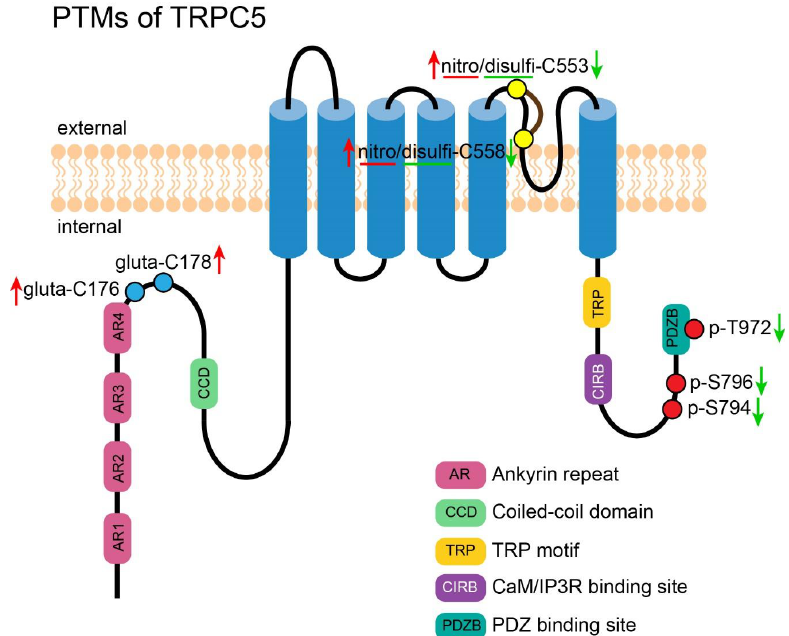
Figure 4. PTMs of TRPC5. A cartoon depicting TRPC5 with its important motifs and PTMs (those exact positions had been reported). PTMs are presented in circles. Red circles represent the reported phosphorylation sites of TRPC5, which are labeled in the format of a “p-amino acid-position”. Yellow circles represent the reported residues for S-nitrosylation and disulfide bond formation, which are labeled in the format of a “nitro/disulfi-amino acid-position”. Blue circles represent the reported residues for S-glutathionylation, which are labeled in in the format of a “gluta-amino acid-position”. The green arrows near the labels denote the PTMs decreasing the channel’s activity. The red arrows near the labels denote the PTMs which increase the channel’s activity.